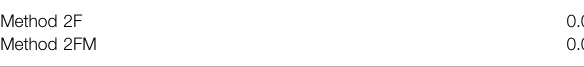
TABLE 12 | RMSER of estimated tension in experimental veri fi cation. Method 2F